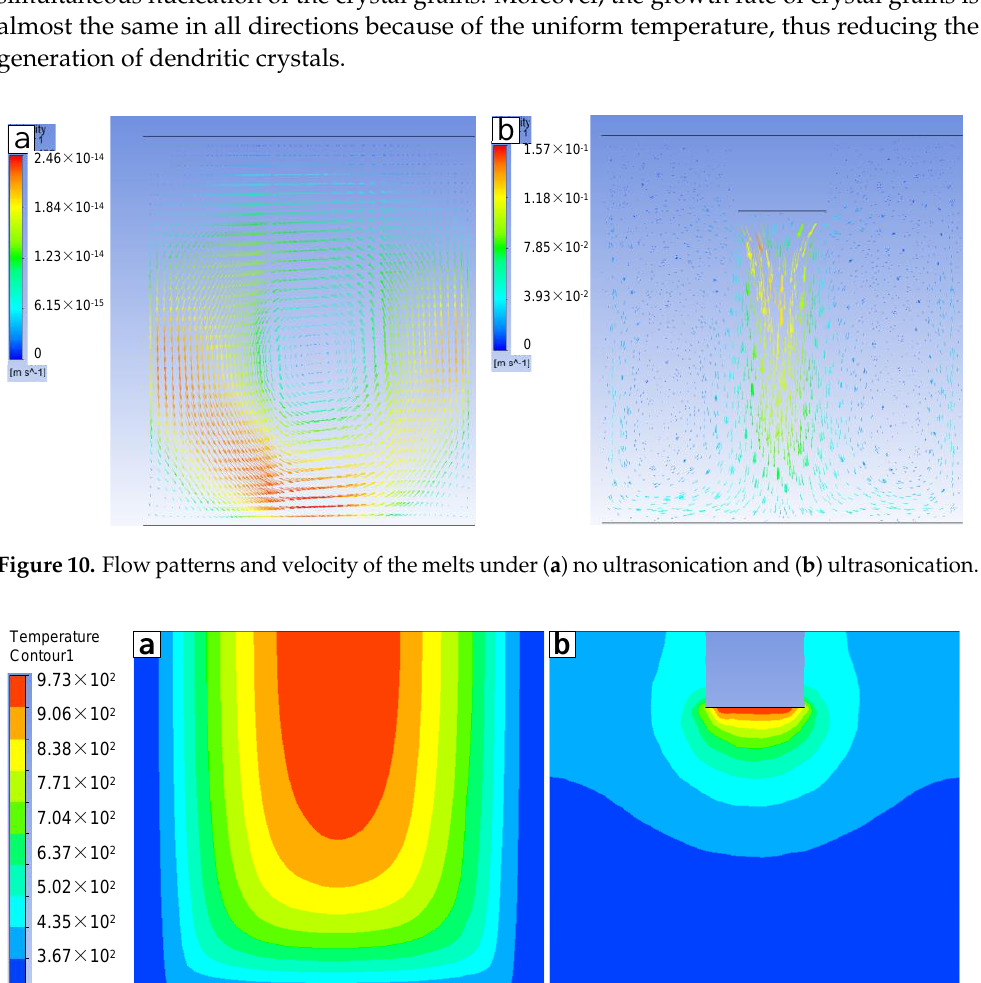
Figure 10. Flow patterns and velocity of the melts under ( a ) no ultrasonication and ( b ) ultrasoni- cation.